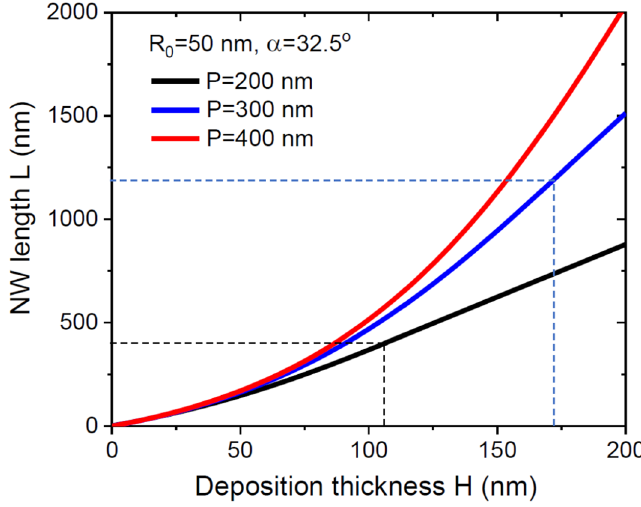
Figure 4. Evolution of the NW length with deposition thickness at a fixed NW radius of 50 nm for α = 32.5 ◦ and three different pitches shown in the legend. The curves are obtained from Equations (11)–(13) using the parameters summarized in Table 1. NW length increases with the pitch for a given H . Fast elongation in the initial stage is followed by a linear increase after the full shadowing of the mask surface, which occurs later for larger pitches. Dashed markers show the corresponding H ∗ and L ∗ for P = 200 and 300 nm. The shadowing length is larger than 2000 nm for P = 400